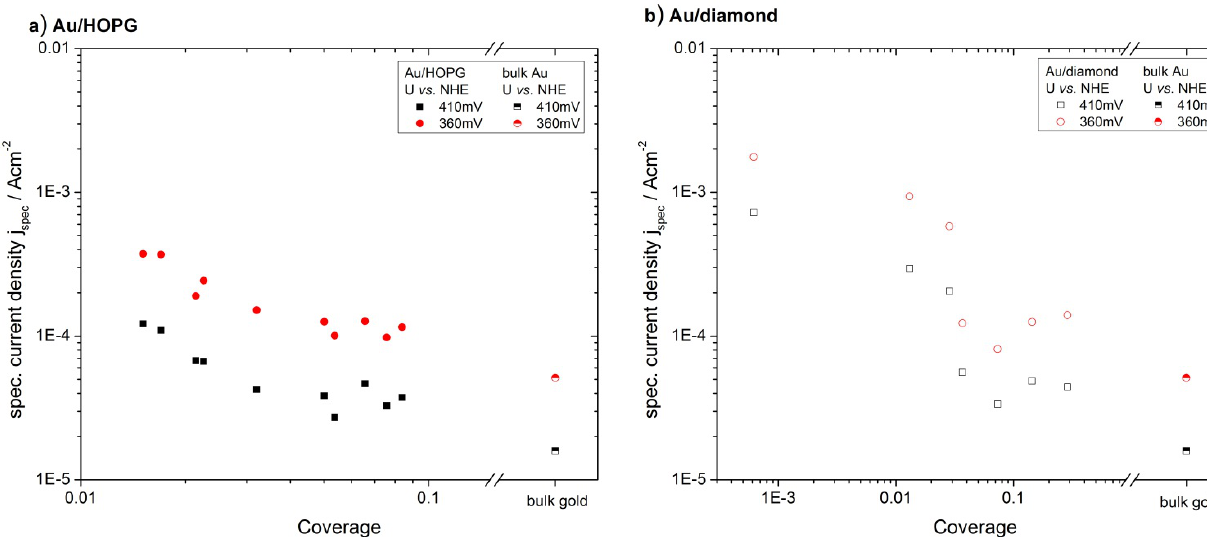
Figure 6. Specific current density for ORR for Au/ HOPG ( a ) and Au/diamond ( b ) evaluated from current-potential curves. The specific current density is increasing with decreasing coverage and decreasing particle height. The data for an extended gold surface was added as a